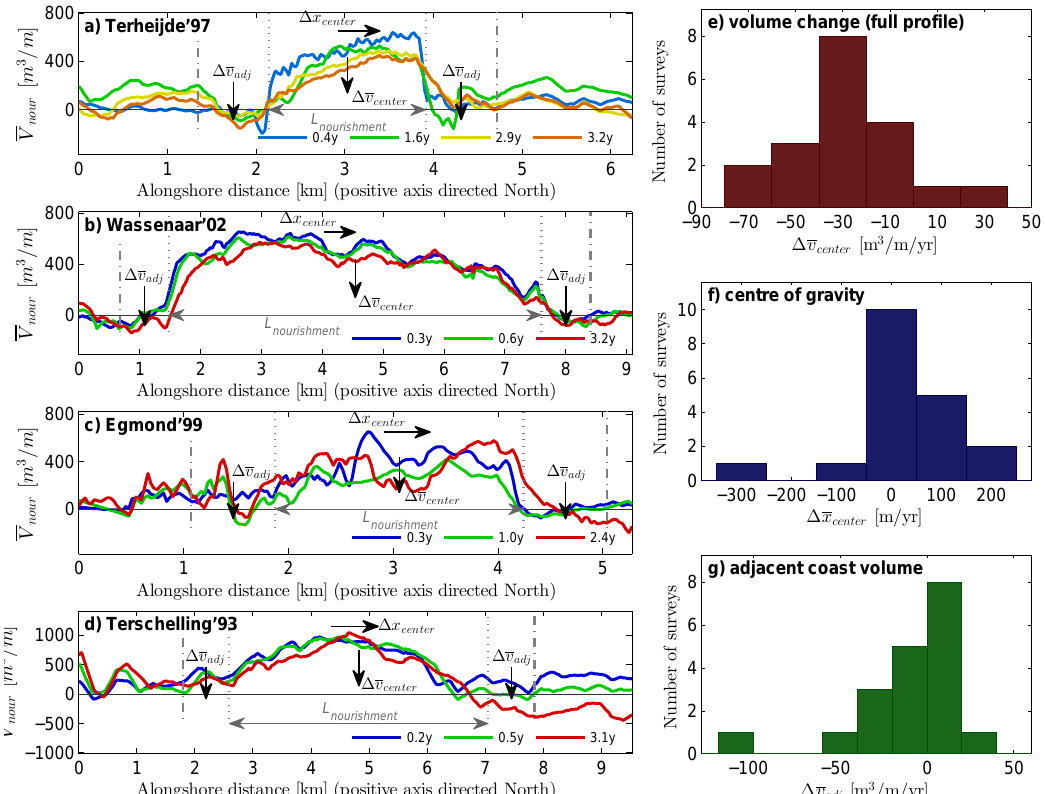
Figure 6. Overview of the alongshore distribution of the added nourishment volume along the coast in the zone from MSL − 10 m to MSL +2 m at 4 representative nourishments from each of the coastal sections. The initial post-construction situation is shown in blue, which gradually changes towards red for the latest considered survey (in red). Dashed vertical lines show the initial extents of the considered nourishment and extent of the adjacent coast